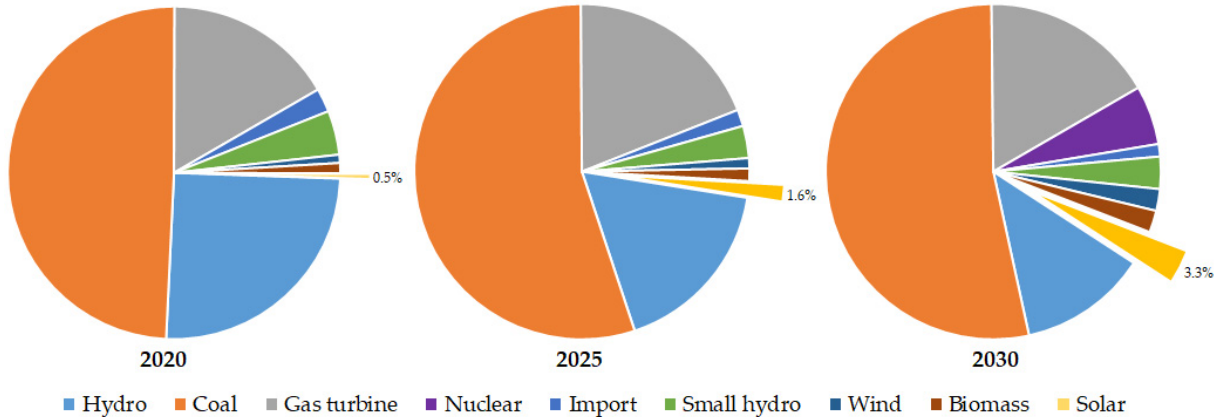
Figure 6. Targets for electricity output by fuels under revised PDP7. Reprinted with permission from Refs. [54,57]. Copyright 2011/2016 Vietnam Government.